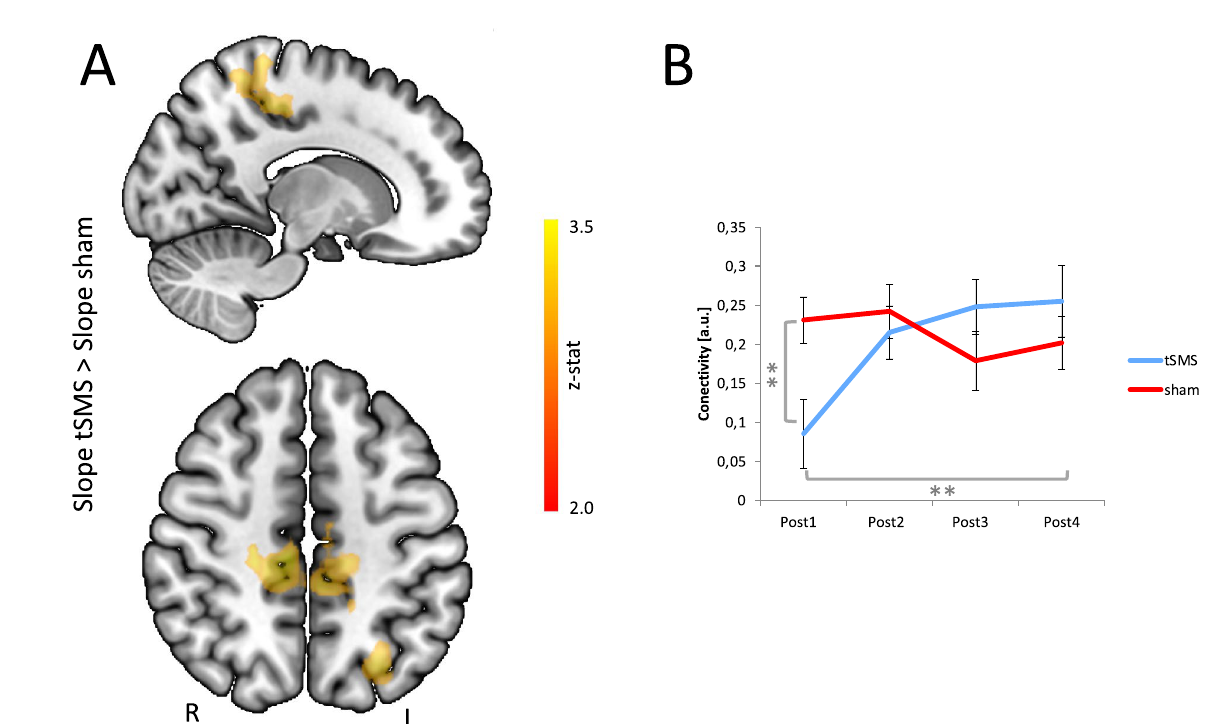
Figure 3. Stimulation by time resting state connectivity analysis. ( A ) Anatomical maps of the comparison between linear slope contrast in the real group and slope contrast in the sham group. Maps determined by z > 2.3 and a (corrected) cluster significance threshold of p = 0.05. ( B ) Time course of the connectivity between the left-M1 seed and the area in which the greatest significant difference occurred when comparing the